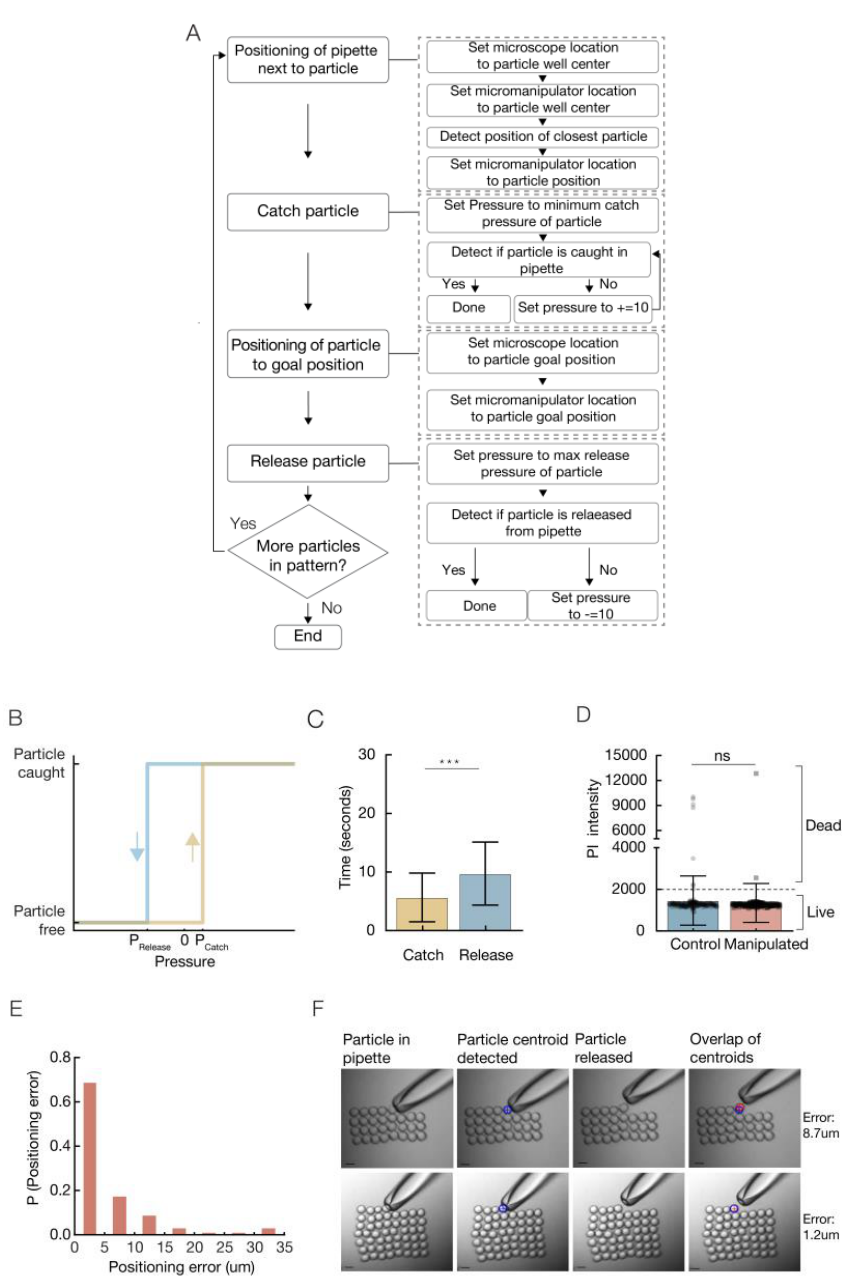
Figure 2. Calibration and Characterization of single particle manipulation. ( A ) Schematic overview of all steps in the assembly process. Each of the steps can be automated. ( B ) Pressure values are calibrated for each particle type. P Catch is the minimum pressure that is required for the particle to be caught on the pipette when the pipette is positioned in near proximity to the particle. A massive suction can lead to unspecificity and deformation of the particles. P Release is the maximum pressure that is required to induce the release of the particle from pipette. As we lower the pressure values, the particle will